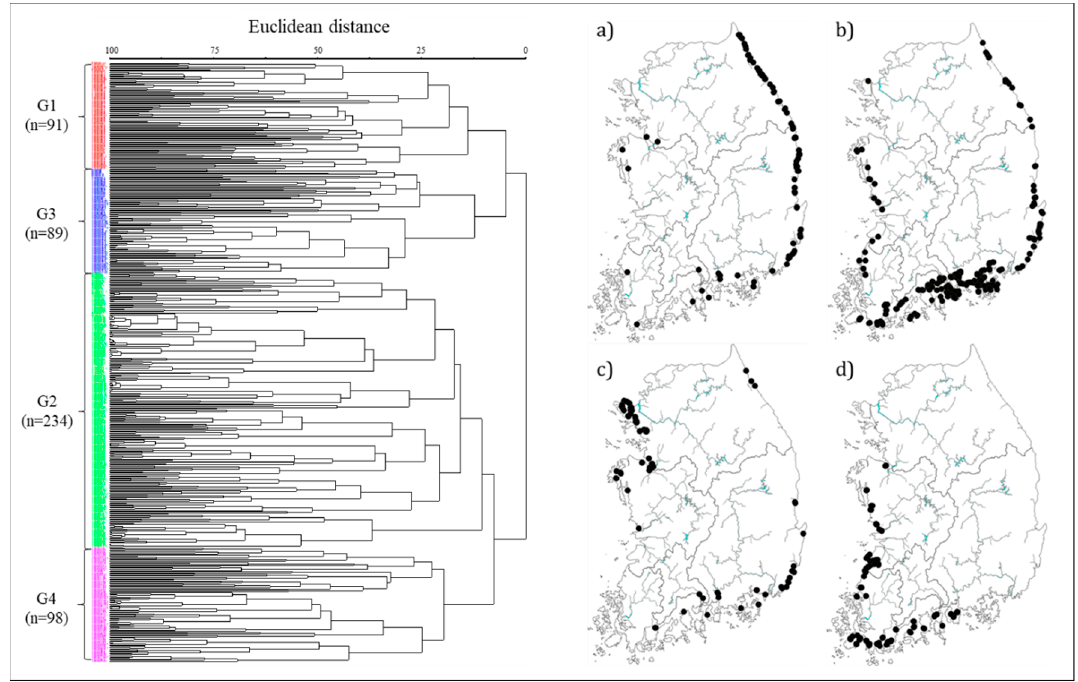
Figure 2. (Left ) Dendrogram illustrating the sites affinity by cluster analysis with diatom abundance and appearance. Each color in figures presents four groups: G1 (red), G2 (green), G3 (blue), and G4 (pink). ( Right ) Geographical distribution patterns of the sampling site in four clusters: ( a ) G1; ( b ) G2; ( c ) G3; and ( d ) G4.